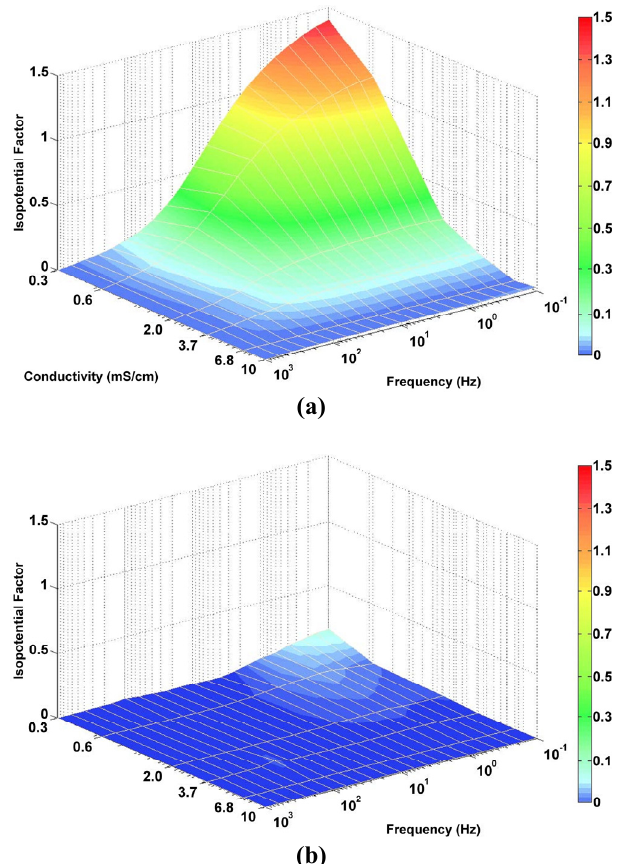
Figure 3: Isopotential interface factor for (a) adjacent electrode system and (b) axial concentric electrode system. A color bar indicates the magnitude of the isopotential interface factor in both 3D graphs. The isopotential factor was higher in adjacent shape compared with axial concentric tetrapolar electrode